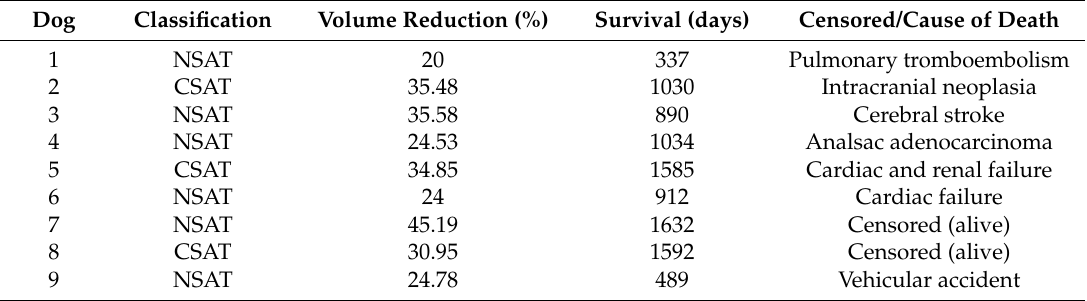
Table 5. Classification of the selected dogs with volume reduction and survical